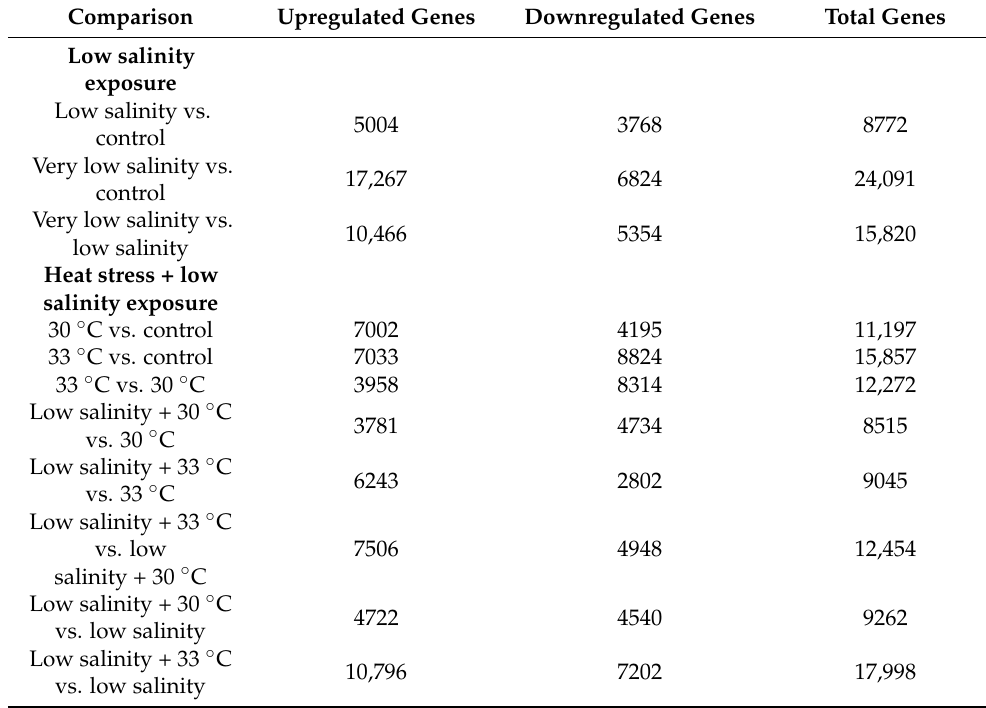
Table 2. Differential gene expression counts in blue mussels ( M. edulis ) subjected to different heat and osmotic stress treatments. Treatment descriptions are as follows: control (23‰ at 5 ◦ C), low salinity (15‰ at 5 ◦ C), very low salinity (5‰ at 5 ◦ C), 30 ◦ C (23‰ at 30 ◦ C), 33 ◦ C (23‰ at 33 ◦ C), low salinity + 30 ◦ C (15‰ at 30 ◦ C), and low salinity + 33 ◦ C (15‰ at 33 ◦ C). Comparison Upregulated Genes Downregulated Genes Total